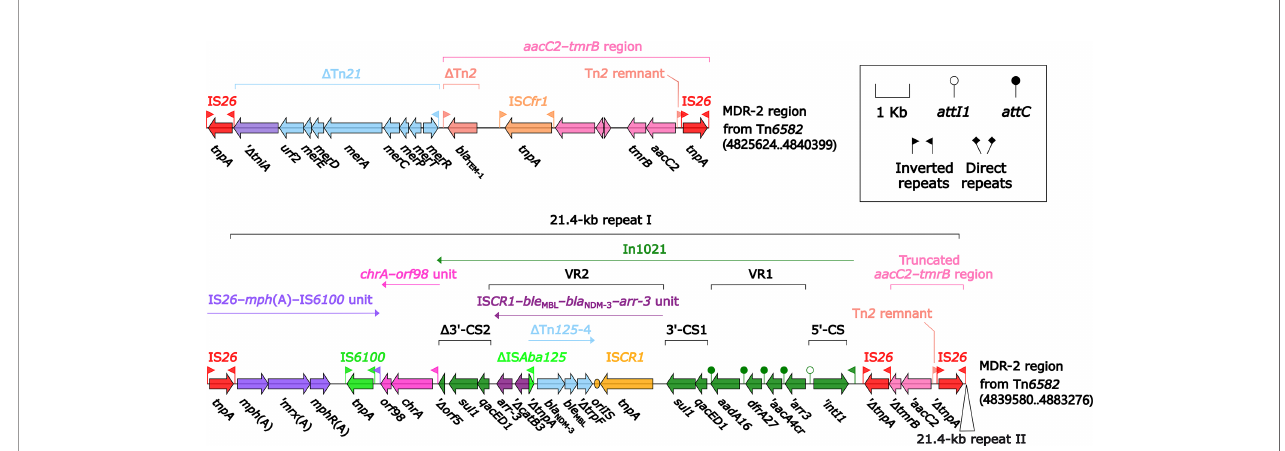
FIGURE 6 | Organization of MDR-2 region from Tn 6582 . Genes are denoted by arrows. Genes, mobile elements, and other features are colored based on their functional classi fi cation. Shading denotes regions of homology (nucleotide identity ≥ 95%). Numbers in brackets indicate nucleotide positions within the chromosome of strain